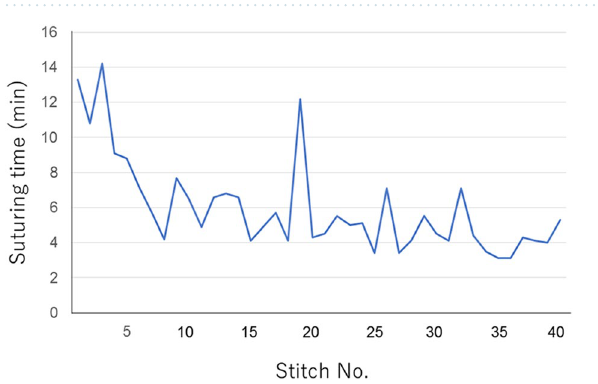
Figure 3. Endoscopic images of anastomosis before and after endoscopic hand suturing. ( a ) Cases sutured by the continuous suturing method (Case 1–5). Case 1, mild stenosis; Case 2, moderate stenosis; Case 3, severe stenosis; Case 4, moderate stenosis; Case 5, mild stenosis. ( b ) Cases sutured by the nodule suturing method (Case 6–10). No stenosis.